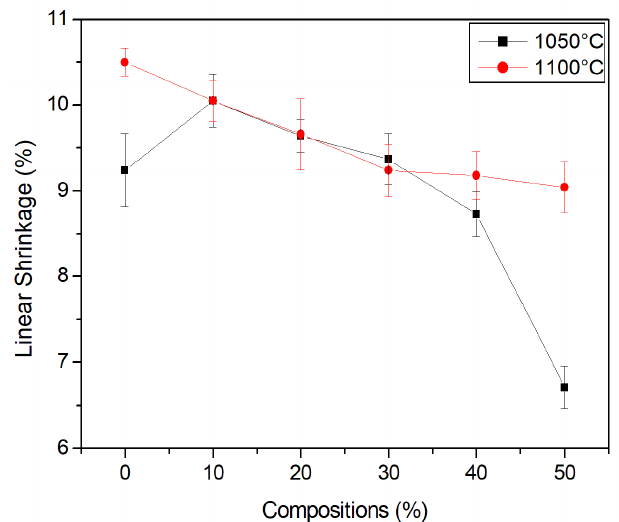
Figure 9. Linear shrinkage of the compositions.